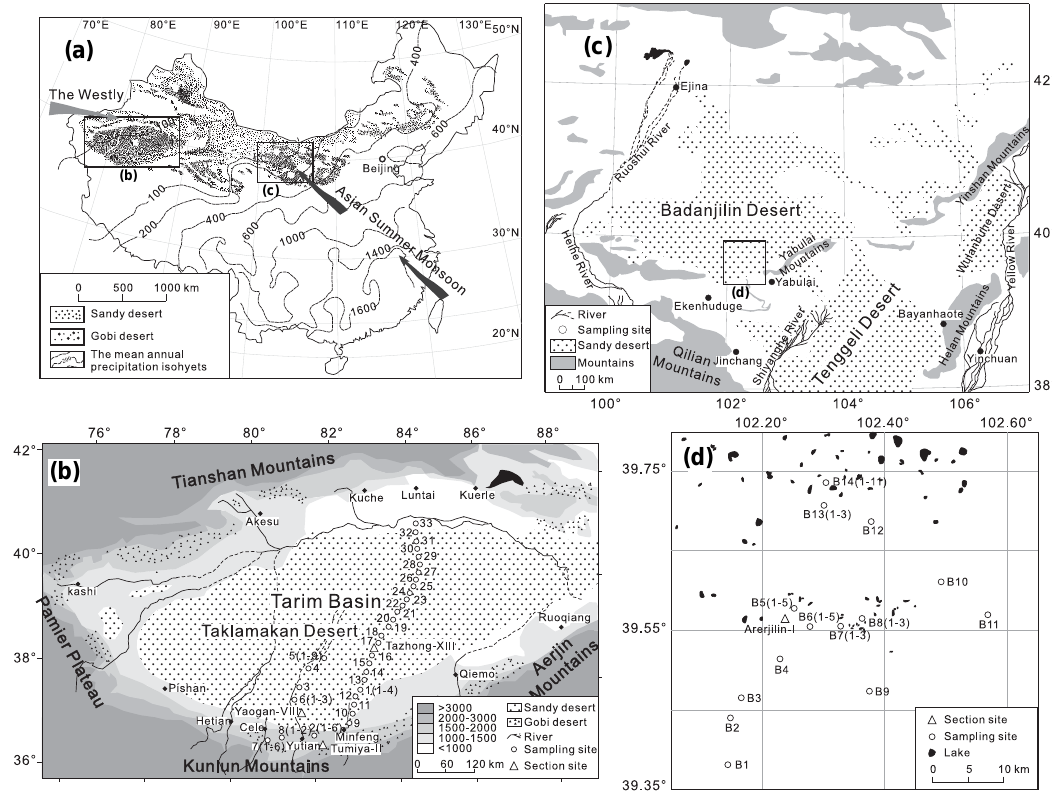
Figure 1. Locations of the study areas and sampling sites in this study. (a) The distributions of deserts and the mean annual precipitation isohyets in China, (b) the Taklamakan Desert, (c) and (d) the Badain Jaran